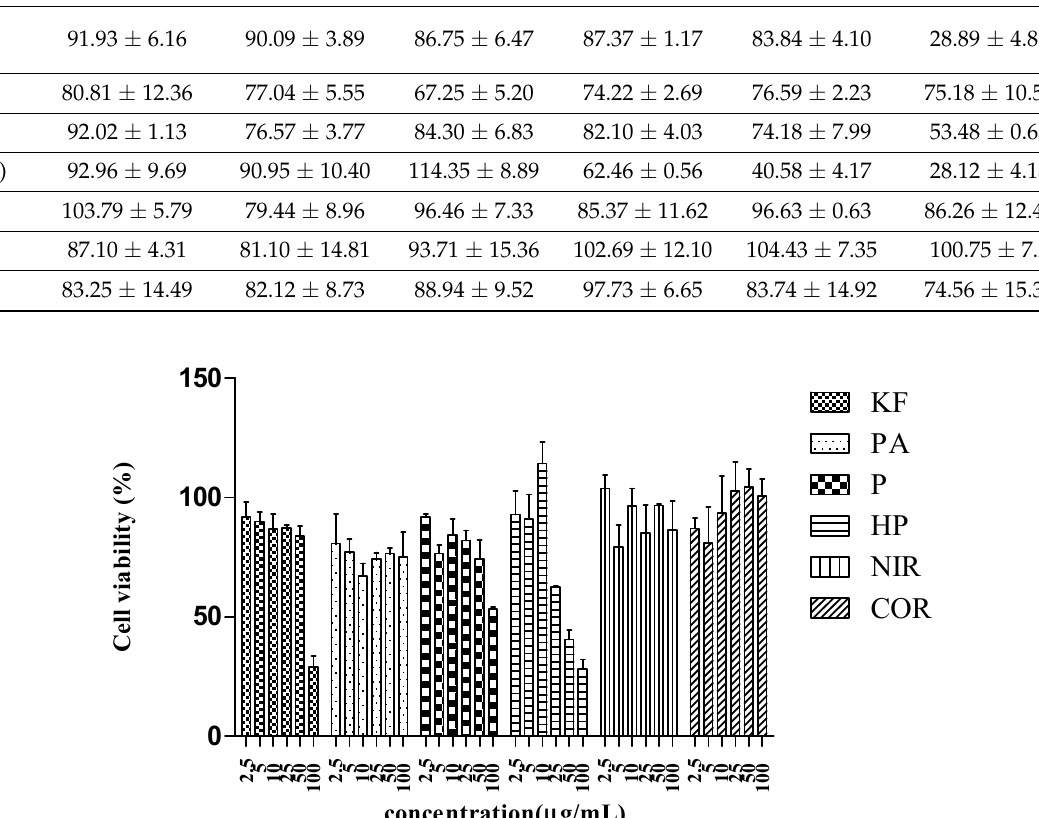
Table 5. Cell viability of P. amarus and its compounds towards the RBL-2H3 cell line. Concentration